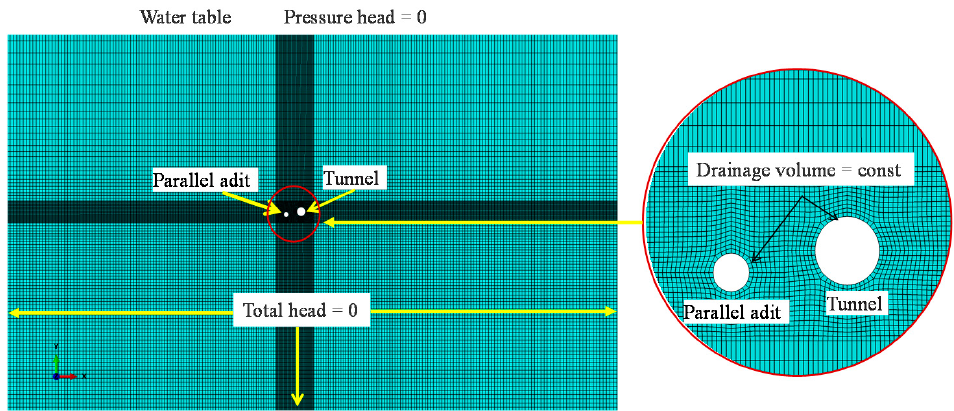
Figure 7. Cross-section of the proposed Jiajiaoshan Tunnel and parallel adit. Table 1. Calculation parameters.